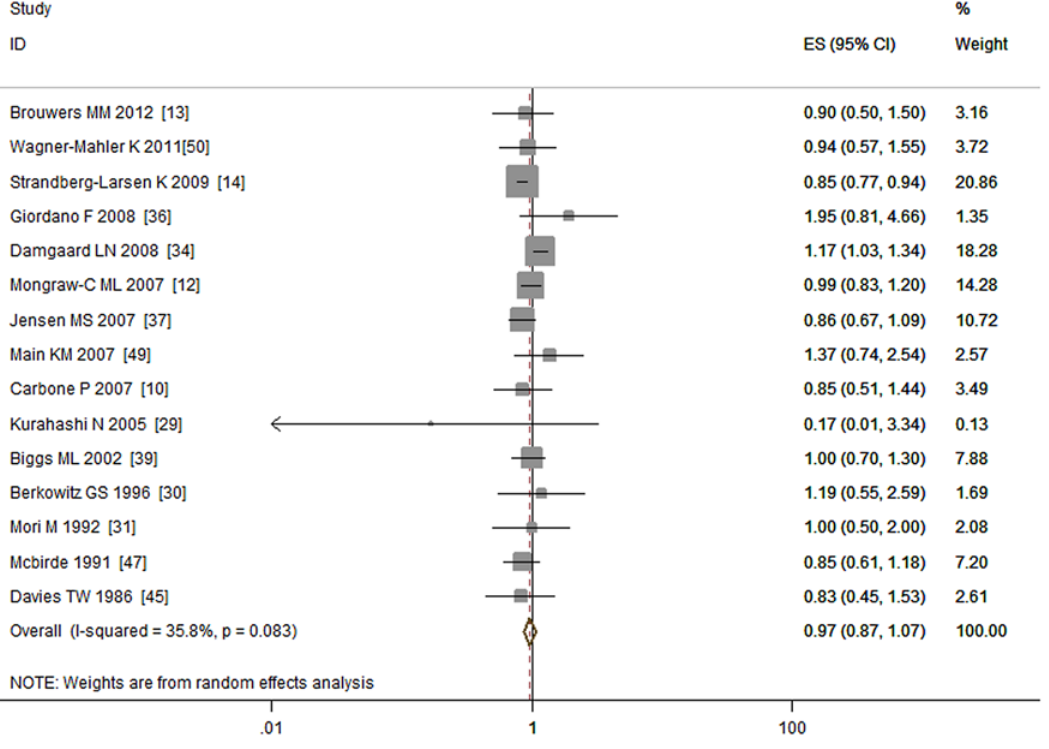
Fig 4. Forest plot for maternal gestational alcohol drinking and risk of